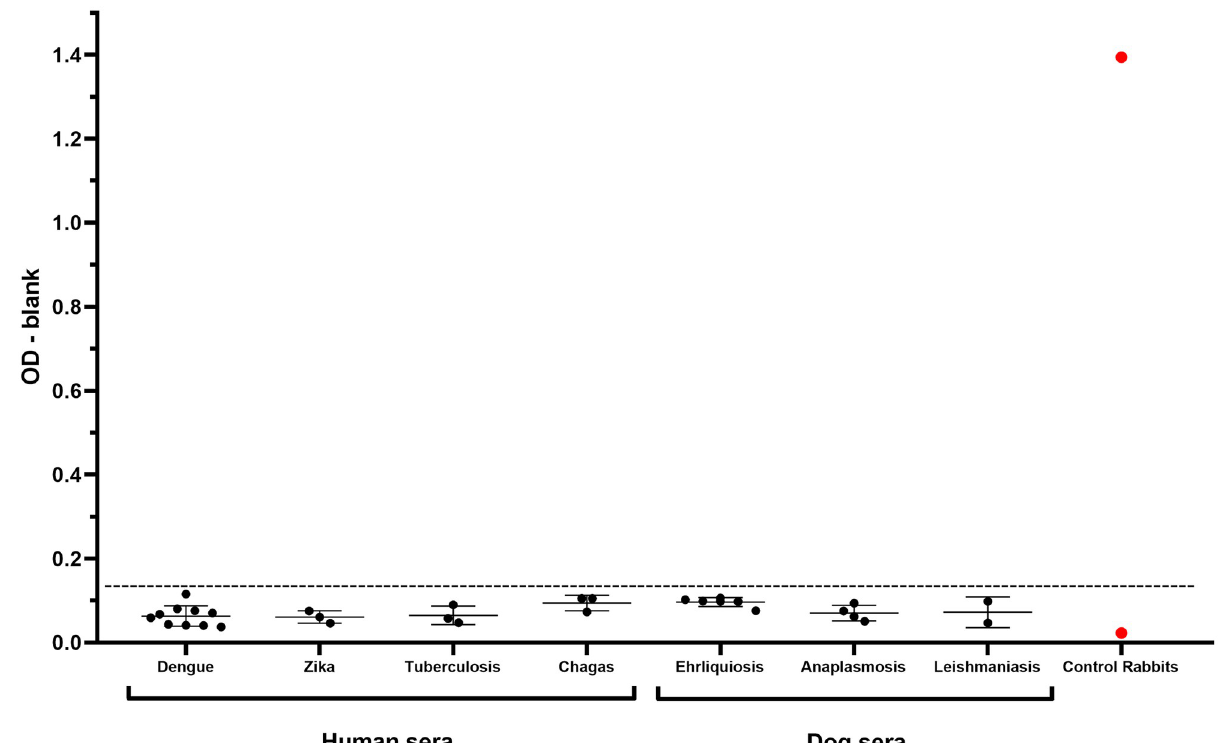
Fig 4. Evaluation of cross-reactivity of the ELISA Protein A method with other common infectious diseases. OD from sera from individuals positive for other infectious diseases, such as dengue (n = 10), Zika (n = 3), tuberculosis (n = 3) and Chagas disease (n = 3) (humans) and ehrlichiosis (n = 6), anaplasmosis (n = 4) and leishmaniasis (n = 2) (dogs). The red data points indicate the positive and negative controls (rabbit sera) and the error bars represent the average values with the 95% confidence